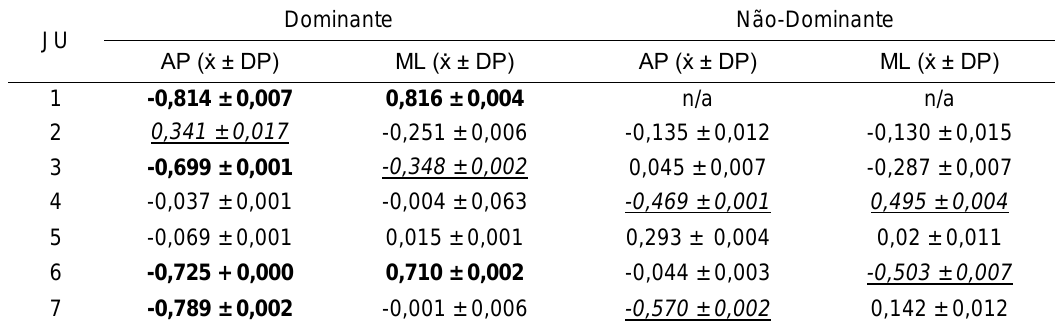
Tabela 2 . Correlação cruzada entre o sinal da FPM e do CP para cada